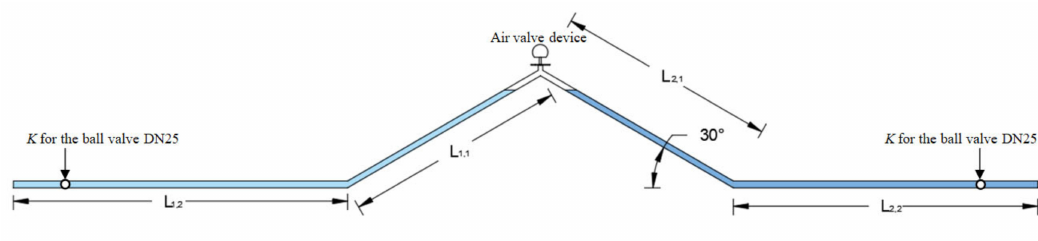
Figure 2. Experimental